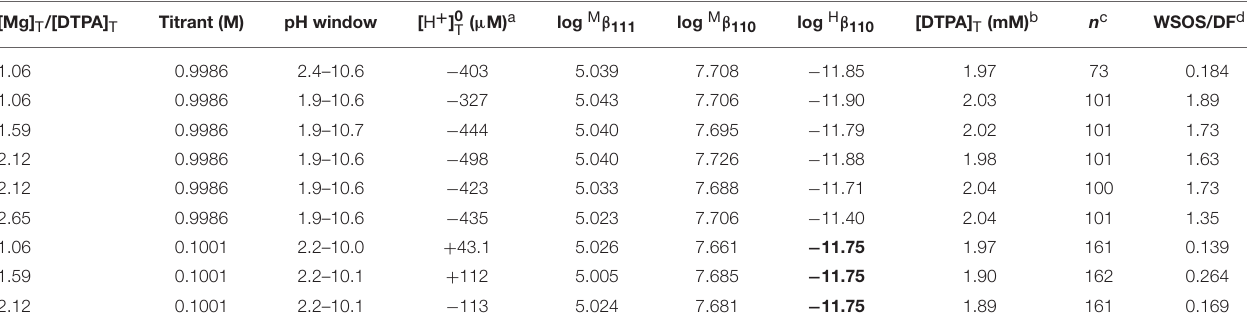
TABLE 4 | Nine titrations of magnesium in 0.7M NaClO 4 solutions containing 2.01mM DTPA (gravimetric